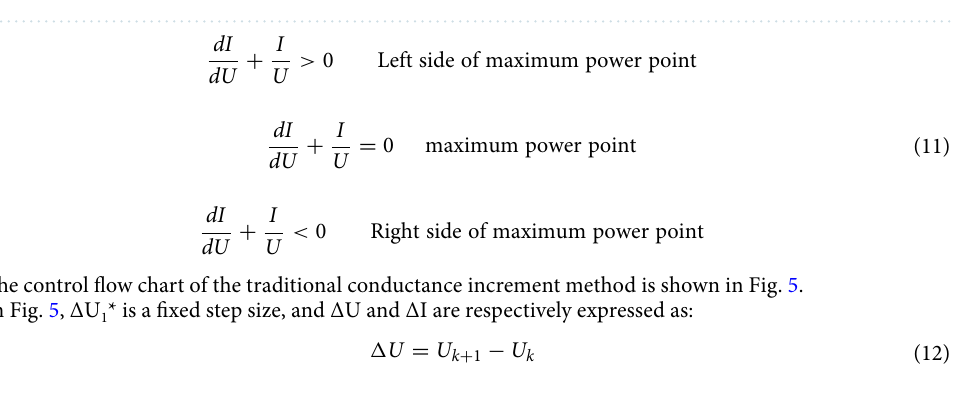
Figure 5. Flow chart of traditional incremental conductance